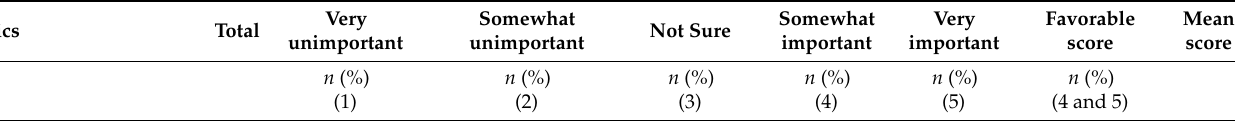
Table 2. Dentists’ attitudes toward DM screening in dental